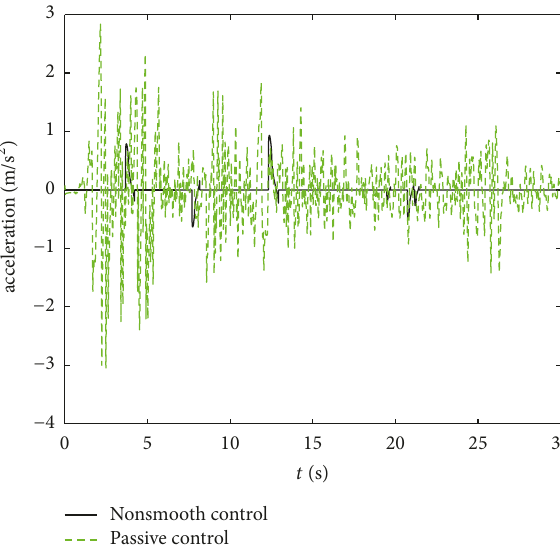
Figure 7: Displacement response of isolation layer.